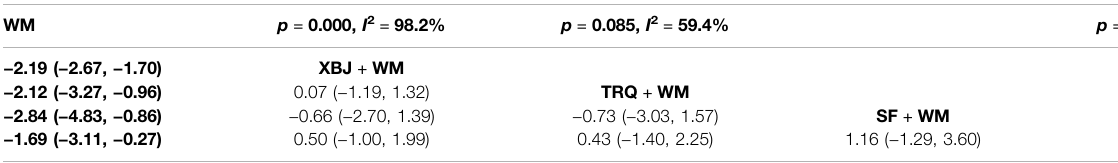
Signi fi cant effects are printed in bold.